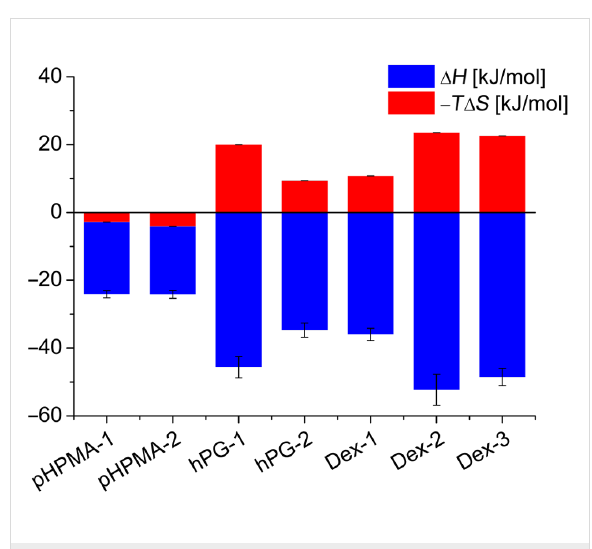
Figure 3: Enthalpic and entropic contributions to the free energy of binding processes of multivalent peptide-polymer conjugates and the tandem WW domain of protein FBP21 determined at 8 °C by ITC